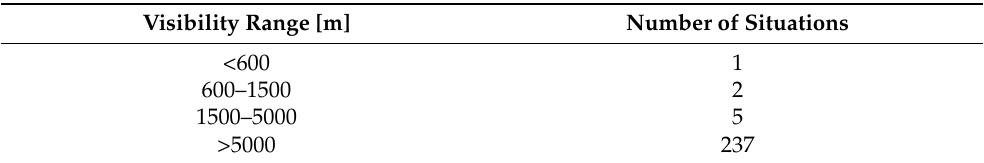
Table 8. Results of the basic validation experiment for assessing the accuracy of the visibility by the proposed system at